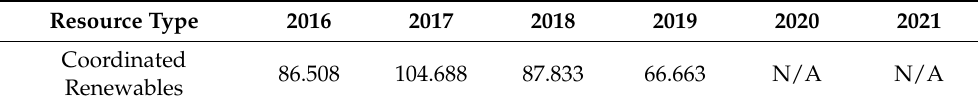
Table 6. Reference prices of the REC in KRW/kWh.